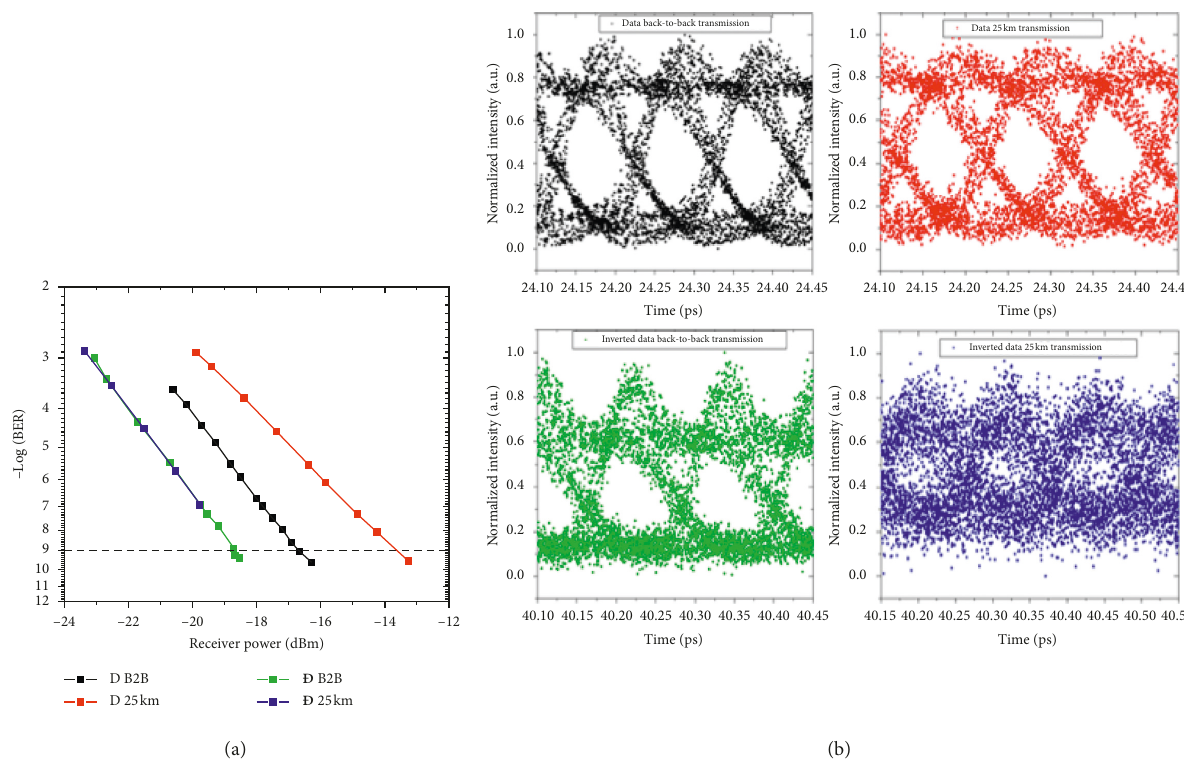
Figure 8: (a) BER measurements showing receiver sensitivity for data (D) and inverted data ( Ɖ ) back-to-back and 25km transmission and (b) eye diagrams for each of the represented (BER) curves.